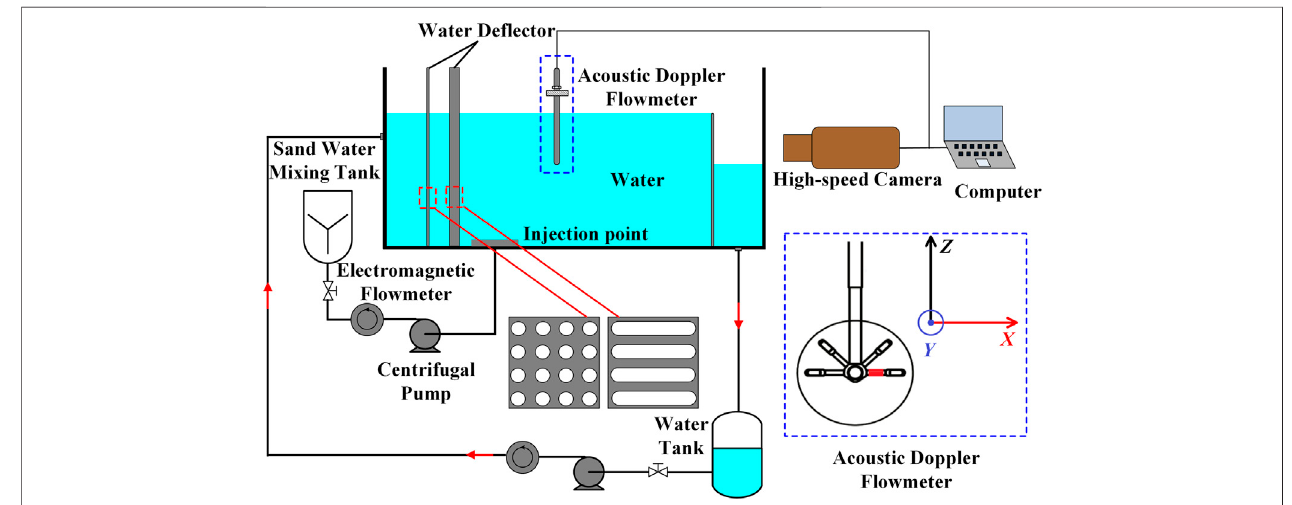
FIGURE 7 | Diagram of hydraulic transport simulation